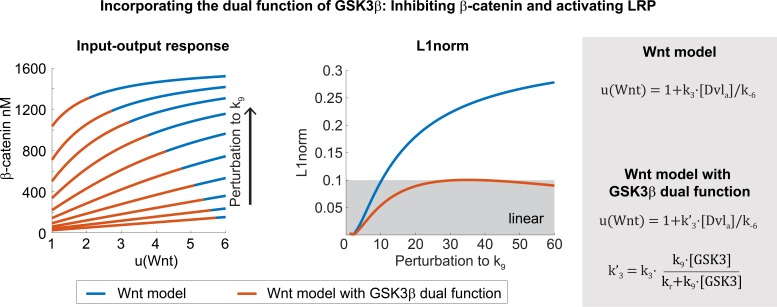
Incorporating into the Wnt model the dual function of GSK3β in phosphorylating β-catenin and LRP5/6.We include the role of GSK3β in phosphorylating LRP5/6 into the input function u(Wnt), such that u(Wnt) is a function of GSK3β and the phosphorylation rate k9 (for simplicity, the same rate as GSK3β phosphorylation of β-catenin), and the reverse rate kr. In both models, β-catenin increases in response to GSK3β inhibition (e.g., by CHIR99021). However, only the model with the dual function of GSK3β shows a decrease in input range that we observed experimentally.